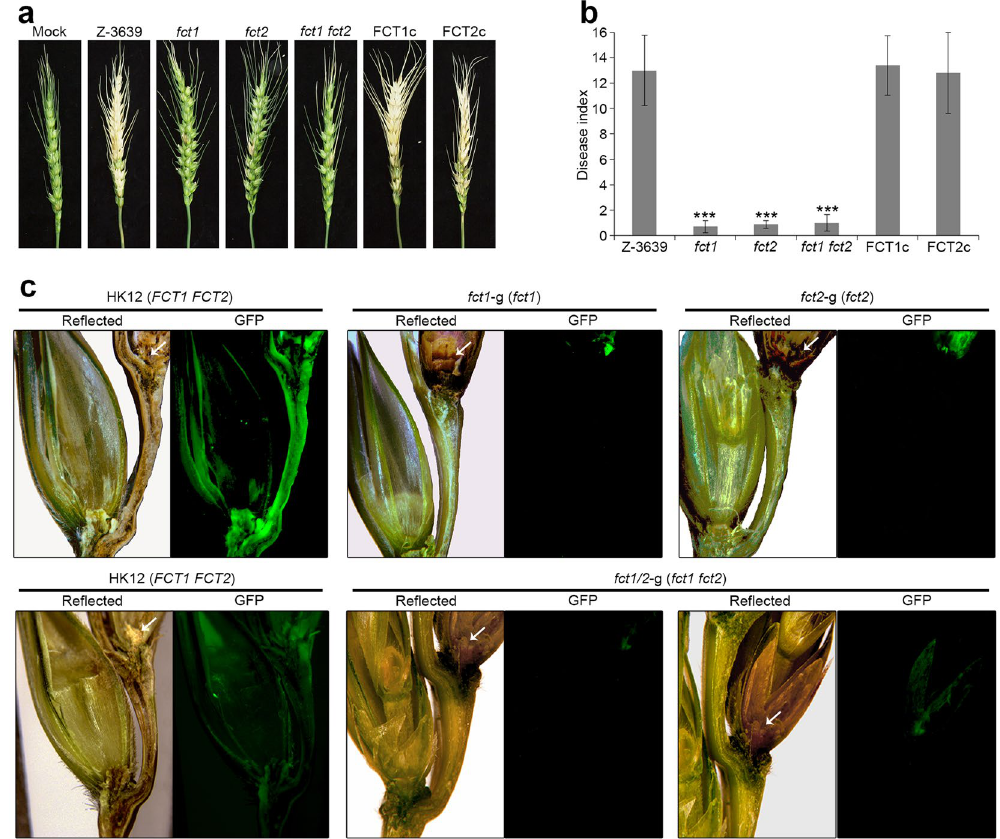
Figure 4. Virulence of F. graminearum strains. ( a ) Virulence on wheat heads. The centre spikelet of each wheat head was injected with 10 μ l of a conidial suspension. Images were captured 21 days after inoculation. ( b ) Disease index. The disease index was estimated as the number of diseased spikelets on each wheat head. Asterisks represent significant difference between the wild-type strain and each mutant (p < 0.001). ( c ) Micrographs of manually generated sections after the infection of wheat. Wheat spikelets were inoculated with conidial suspensions from strains expressing GFP in the cytoplasm (HK12, fct1 -g, fct2 -g, and fct1/2 -g). Infected wheat heads were longitudinally dissected 6 days after inoculation and examined under a fluorescence microscope. GFP fluorescence indicates hyphal spreading from the inoculation points. Arrowheads mark the inoculated spikelets. Reflected, reflected light.